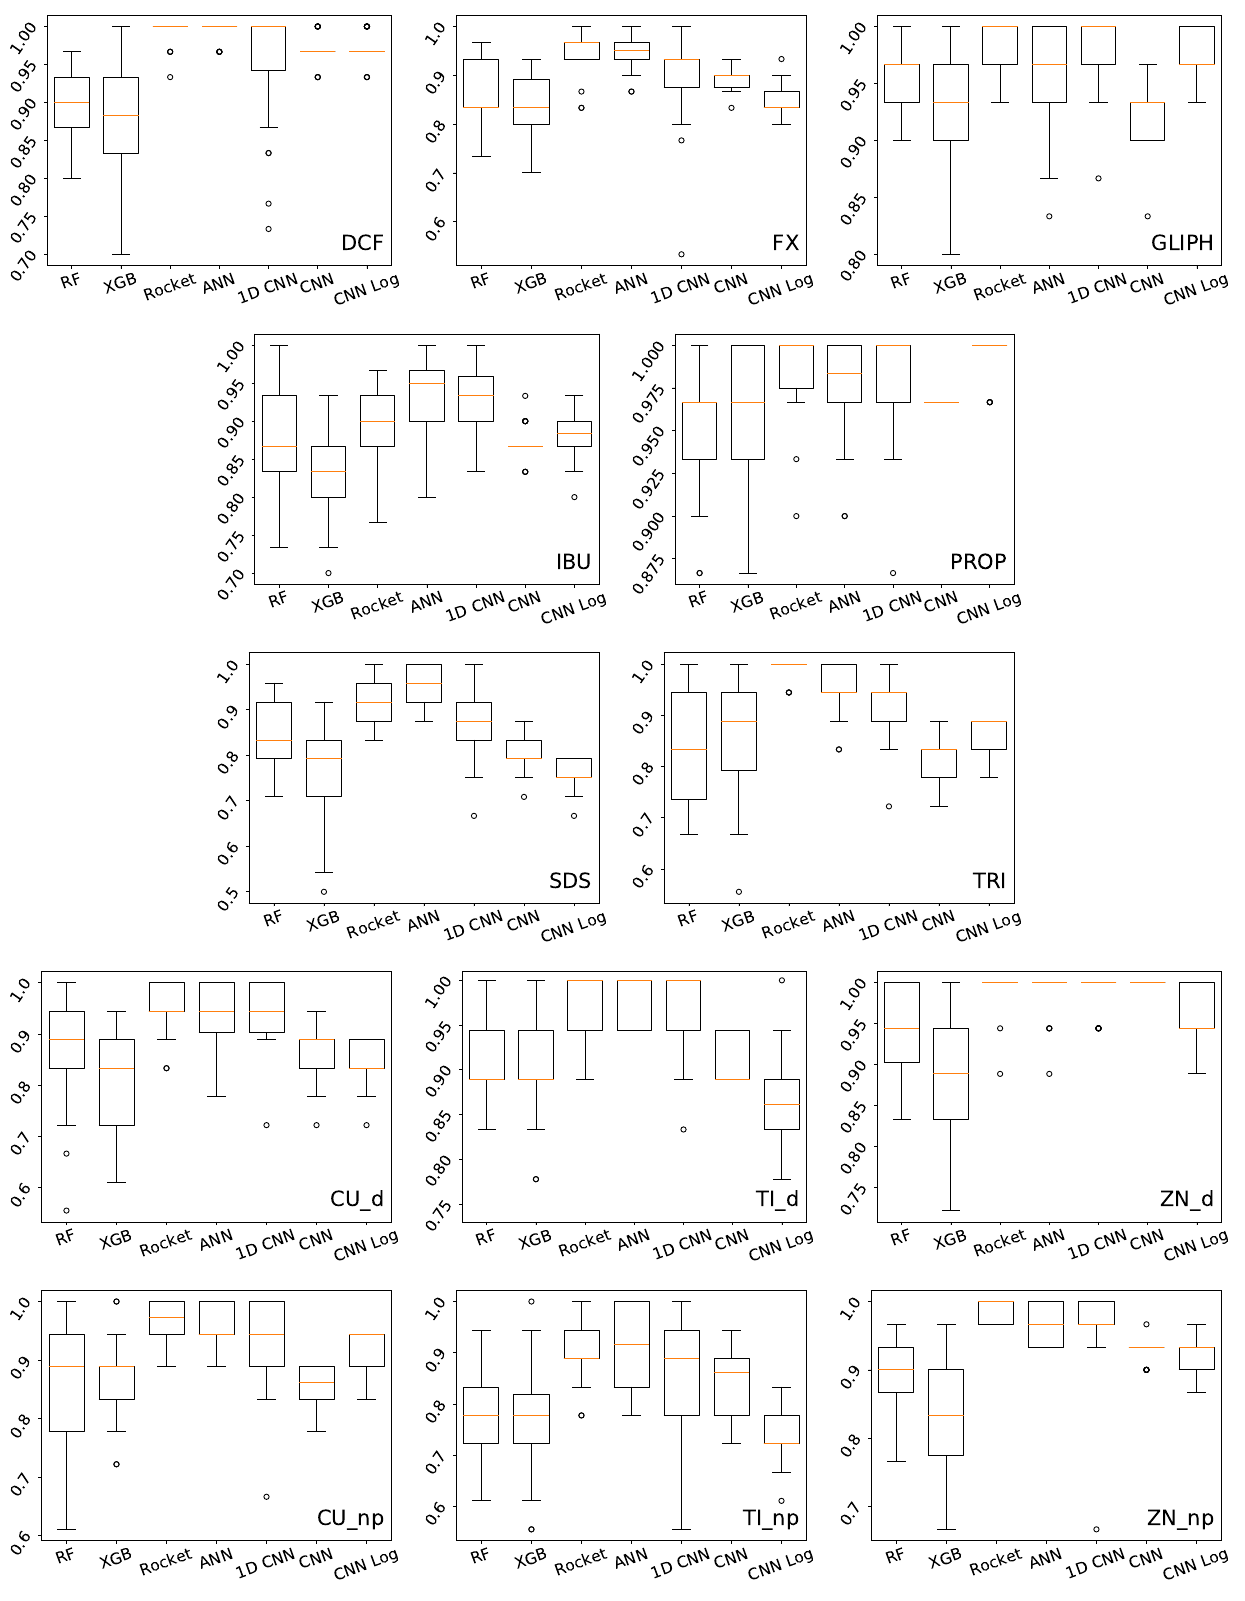
Figure 5. Boxplots showing the distribution of accuracy obtained by each method on the test set, in 30 independent runs of predicting the concentration of each given